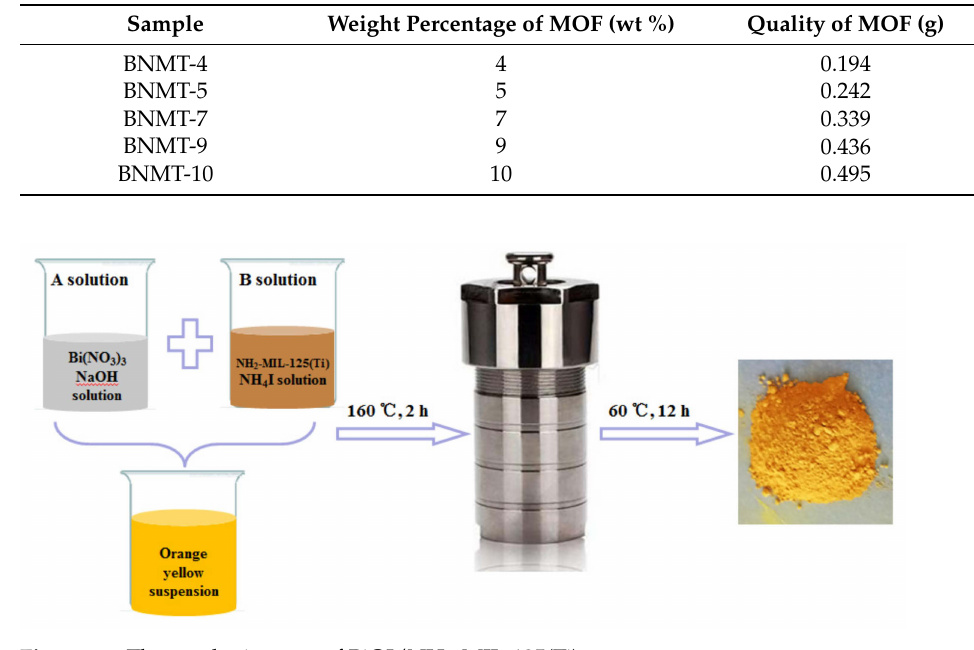
Figure 13. The synthetic route of BiOI/NH 2